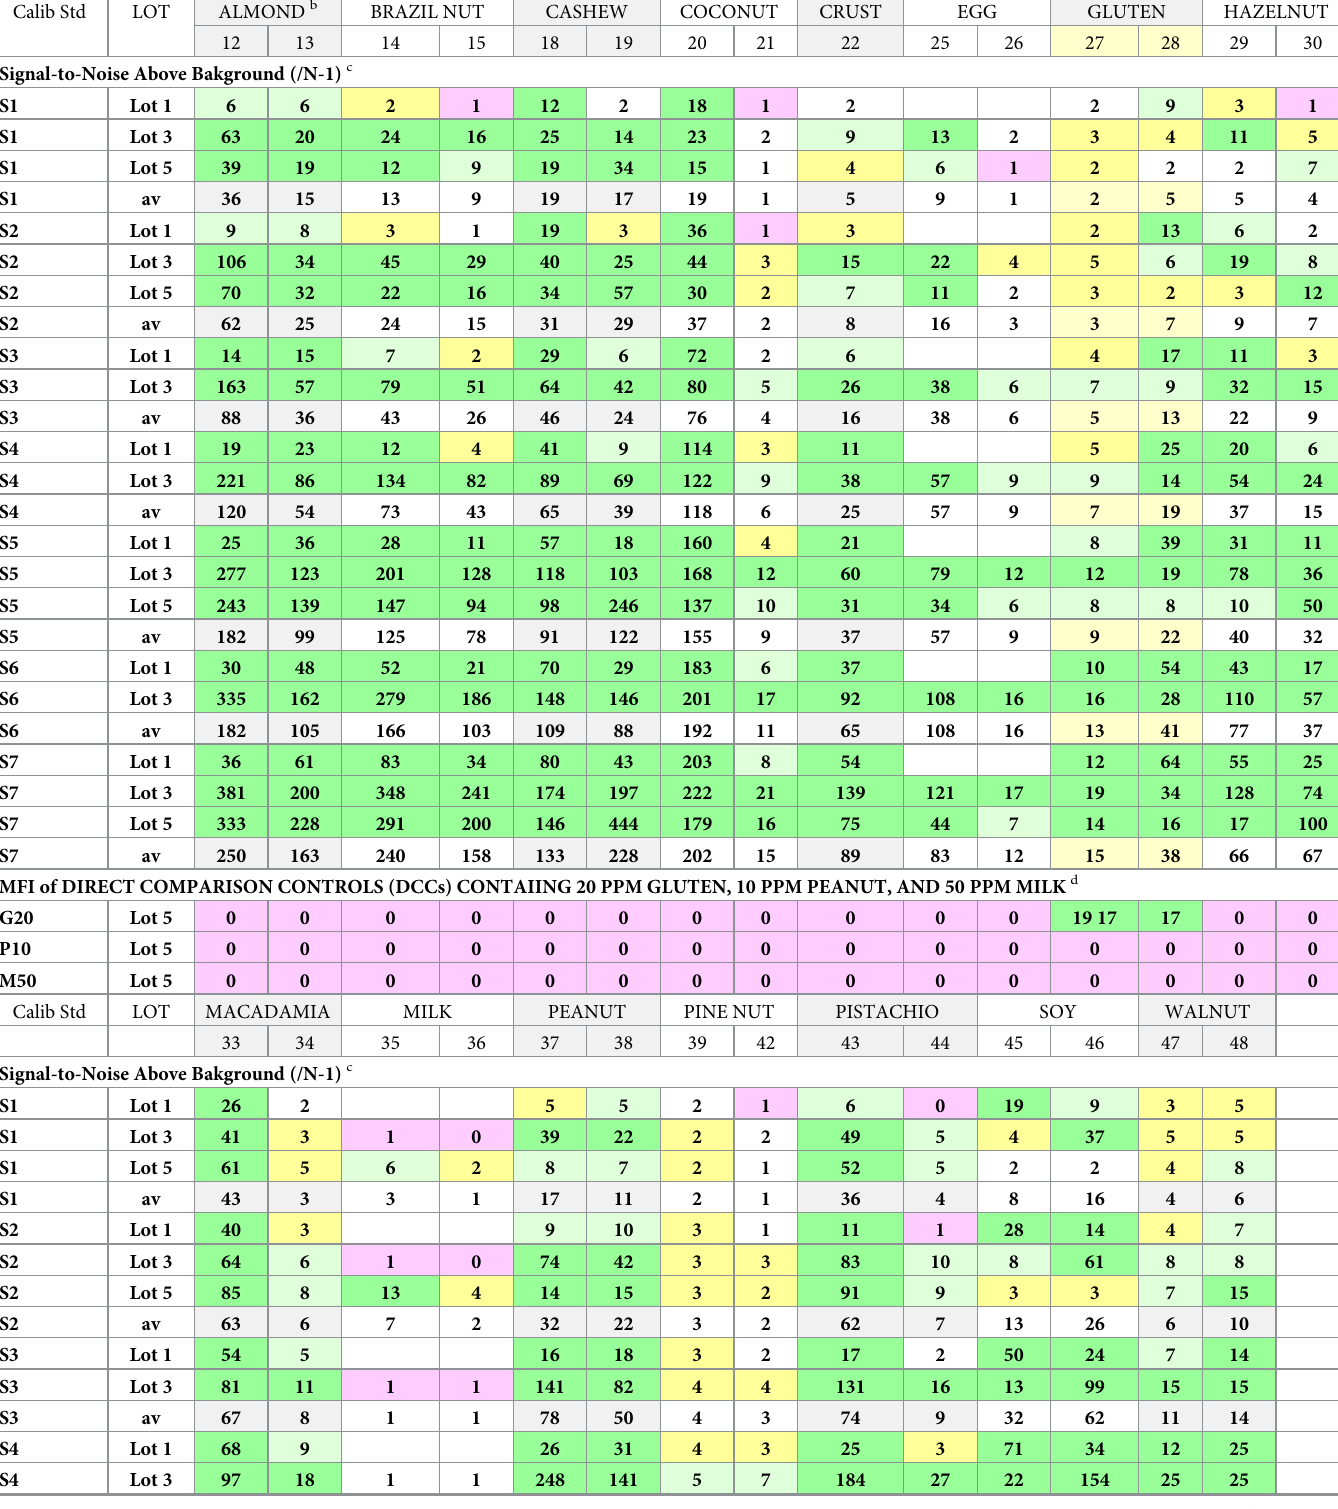
Table 5. Lot-to-lot variation in signal / noise above background (S/N - 1) of calibration standards over five years a . Calib Std